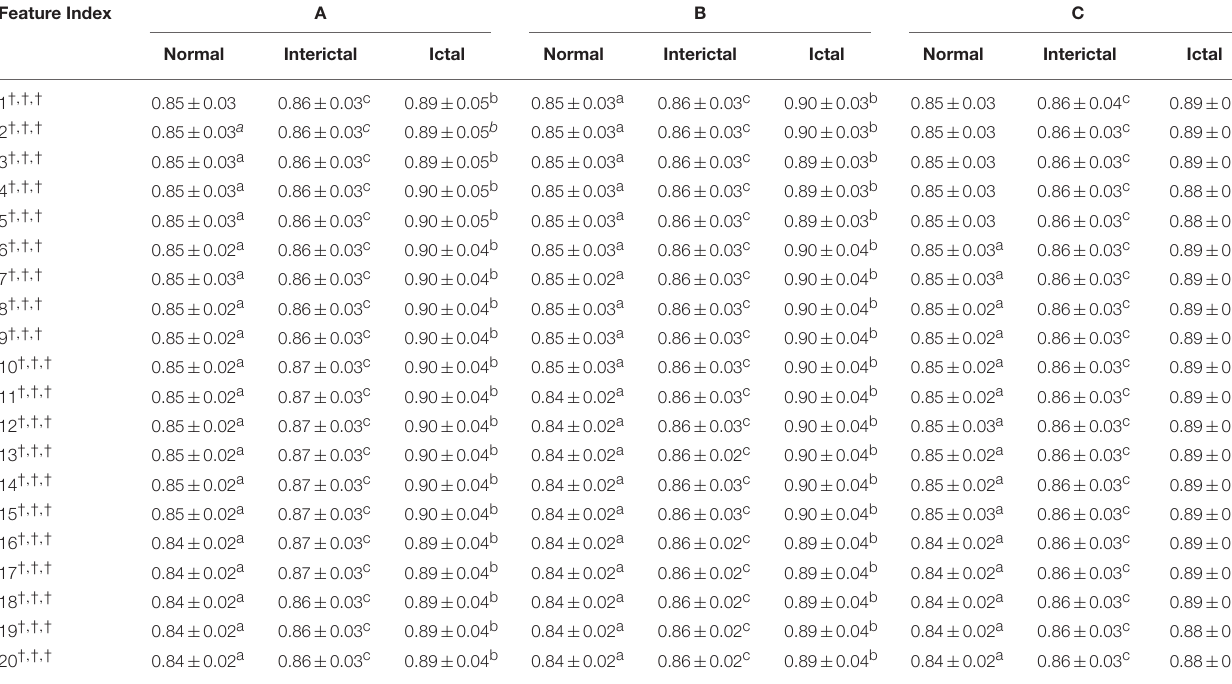
TABLE 1 | DistEn of normal, interictal, and ictal EEG